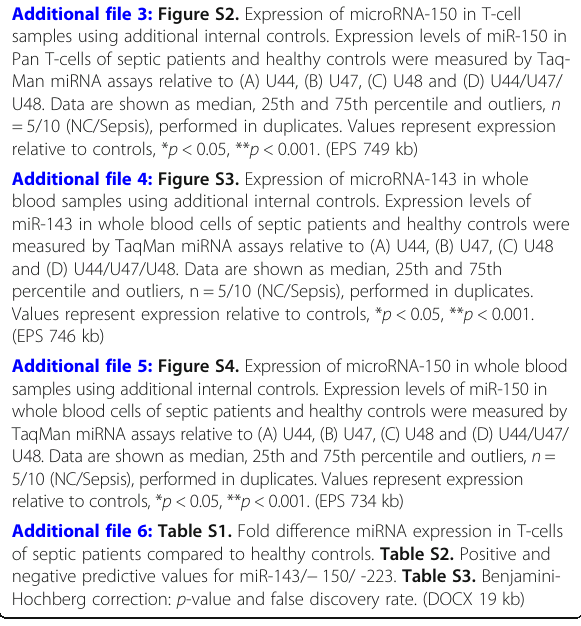
Additional file 3: Figure S2. Expression of microRNA-150 in T-cell samples using additional internal controls. Expression levels of miR-150 in Pan T-cells of septic patients and healthy controls were measured by Taq- Man miRNA assays relative to (A) U44, (B) U47, (C) U48 and (D) U44/U47/ U48. Data are shown as median, 25th and 75th percentile and outliers, n =5/10 (NC/Sepsis), performed in duplicates. Values represent expression Additional file 4: Figure S3. Expression of microRNA-143 in whole blood samples using additional internal controls. Expression levels of miR-143 in whole blood cells of septic patients and healthy controls were measured by TaqMan miRNA assays relative to (A) U44, (B) U47, (C) U48 and (D) U44/U47/U48. Data are shown as median, 25th and 75th percentile and outliers, n =5/10 (NC/Sepsis), performed in duplicates. Values represent expression relative to controls, * p < 0.05, ** p < 0.001. (EPS 746 kb) Additional file 5: Figure S4. Expression of microRNA-150 in whole blood samples using additional internal controls. Expression levels of miR-150 in whole blood cells of septic patients and healthy controls were measured by TaqMan miRNA assays relative to (A) U44, (B) U47, (C) U48 and (D) U44/U47/ U48. Data are shown as median, 25th and 75th percentile and outliers, n = 5/10 (NC/Sepsis), performed in duplicates. Values represent expression Additional file 6: Table S1. Fold difference miRNA expression in T-cells of septic patients compared to healthy controls. Table S2. Positive and negative predictive values for miR-143/ − 150/ -223. Table S3. Benjamini- Hochberg correction: p -value and false discovery rate. (DOCX 19